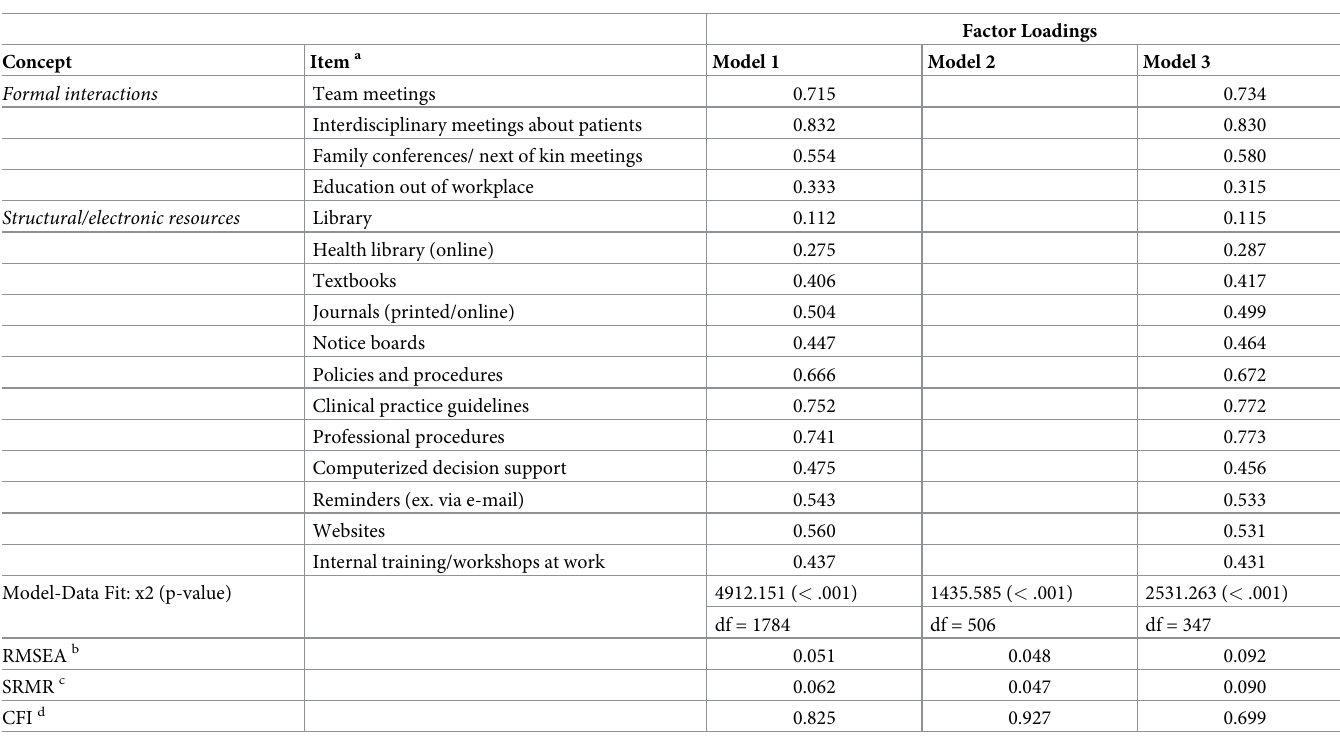
a Horizontal lines separate factors within each model, i.e., there are 10 factors in Model 1, seven in Model 2 and three in Model 3. b RMSEA = root mean square error of approximation. c